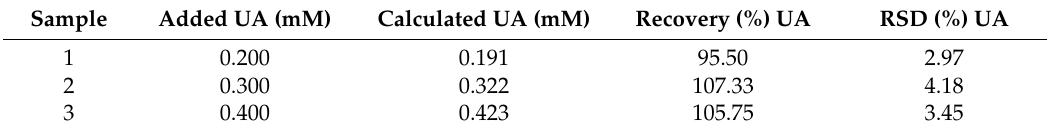
Table 2. Recovery ratios of uric acid in 20% serum.